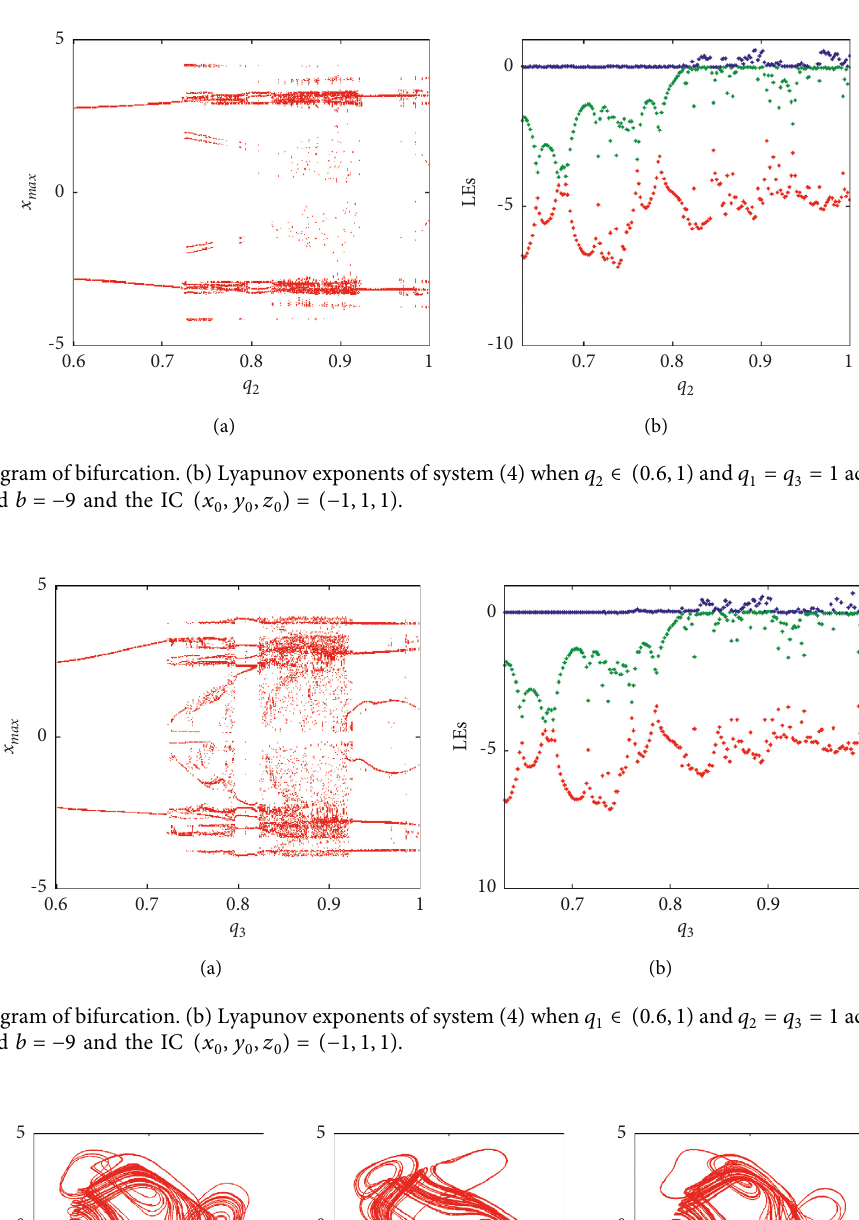
, y ,z ) � (− 1 , 1 , 1 ) . 0 0 0